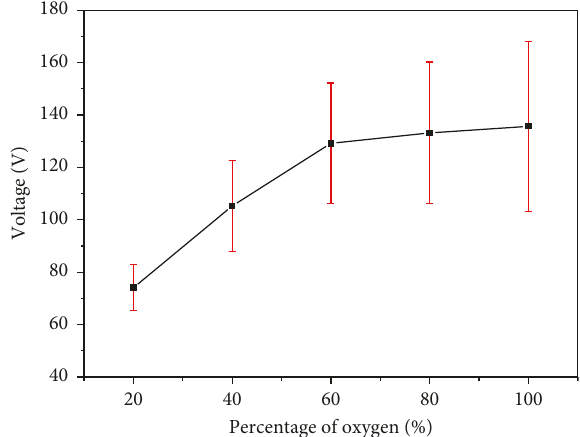
Figure 7: Mean arc voltage of the plasma igniter under different O concentrations. The error bars represented the standard deviation of arc voltage from 0ms to 4ms presented in Figure